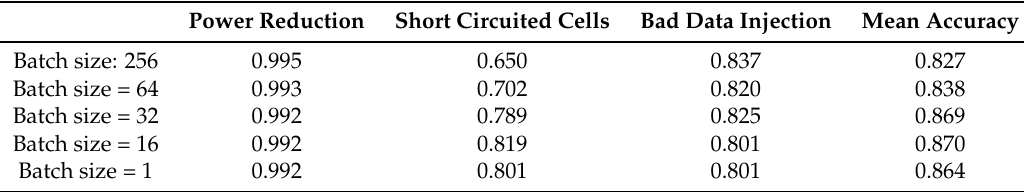
Table 4. Impact of the batch size on accuracy.